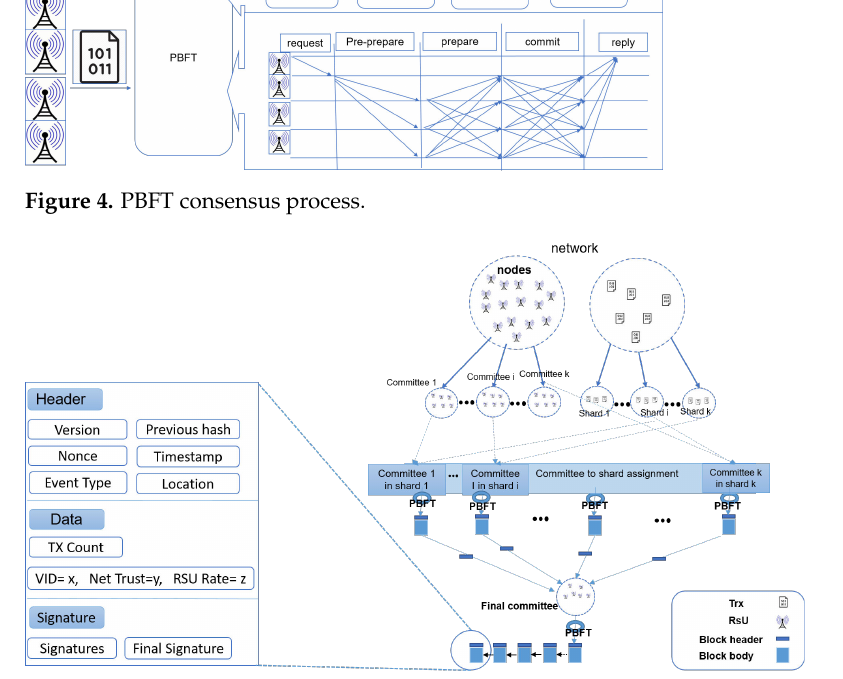
Figure 5. Sharding protocol in SBTMS.